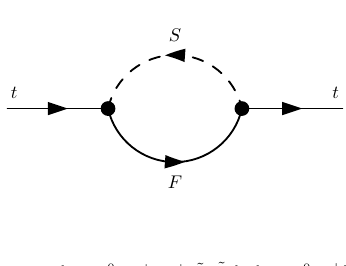
Figure 7 . Generic one-loop self-energies of the top quark contributing at O ( (cid:11) t ) to the renormaliza- tion of m t . A summation over all internal particles with indices a = 1 ; : : : ; 5, b = 1 ; 2 and c = 3 ; 4 ; 5 is